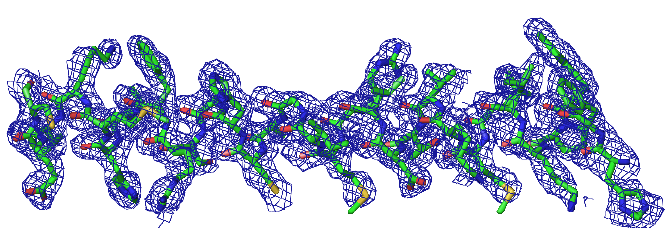
Figure 4. Comparison of calculated electron density with the reconstructed model on an α -helix separated from the rest of the test structure.